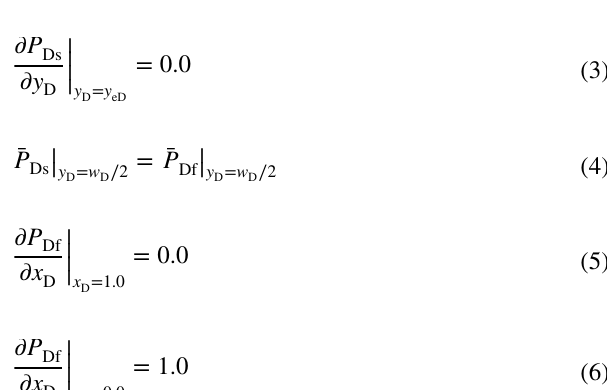
Fig. 3 Fractal pours media of the stimulated reservoir